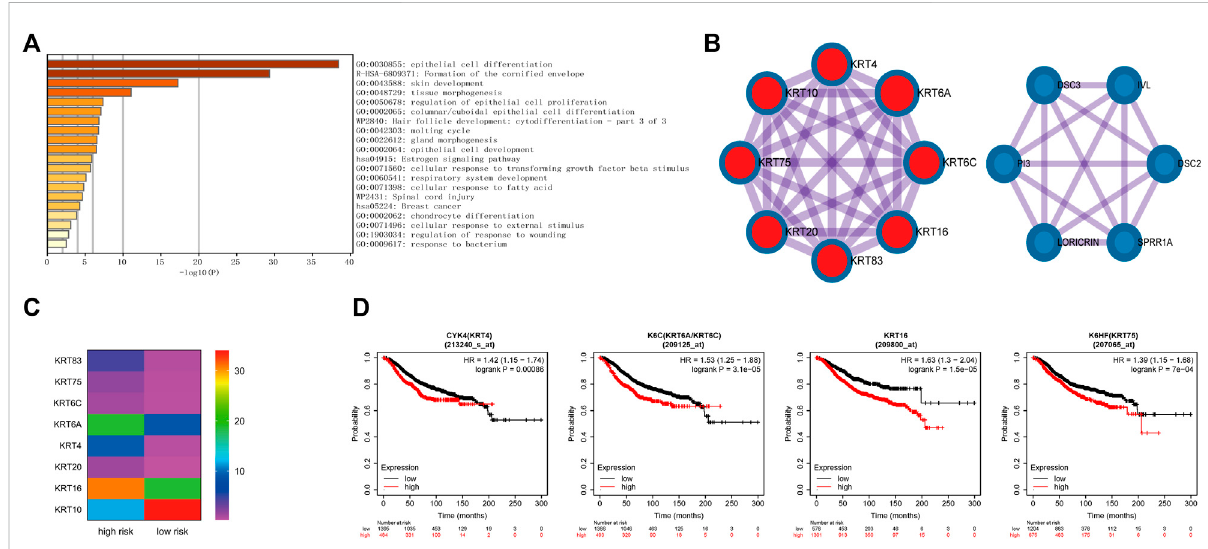
FIGURE 7 Identi fi cationoftheformation ofcorni fi edenvelopepathway involved inthedifferentiallyexpressedgenesbetween high-andlow-risk groups. (A) . The enrichment pathways of genes involved in the formation of the corni fi ed envelope pathway. (B) . The genes of two main MCODE modules analyzed by Cytoscape. (C) . The expression levels of genes in keratin-related MCODE module between the high- and low-risk groups. (D) . Kaplan – Meier curves of overall survival of some genes in keratin-related MCODE module for breast cancer patients in Kaplan-Meier Plotter